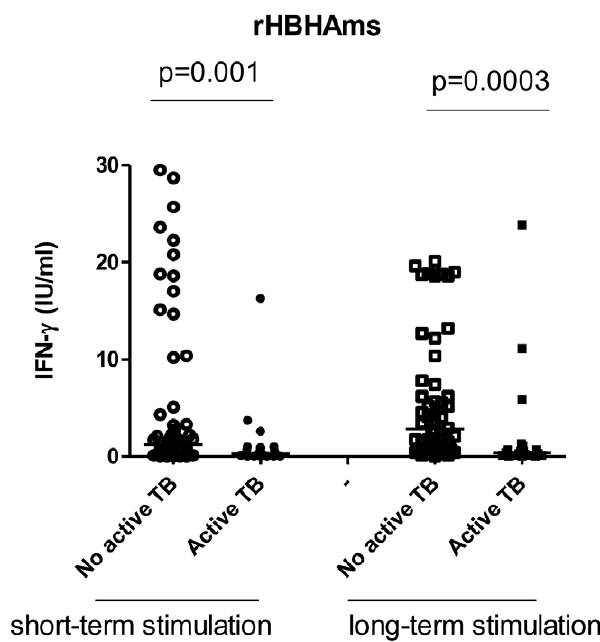
Figure 3. Response to rHBHAms is significantly impaired in patients with active TB after short- or long- term stimulation. A significant difference was found for the IFN- c response to rHBHA between the subjects with and without active TB (p=0.001) evaluated by short- or long- term stimulation.